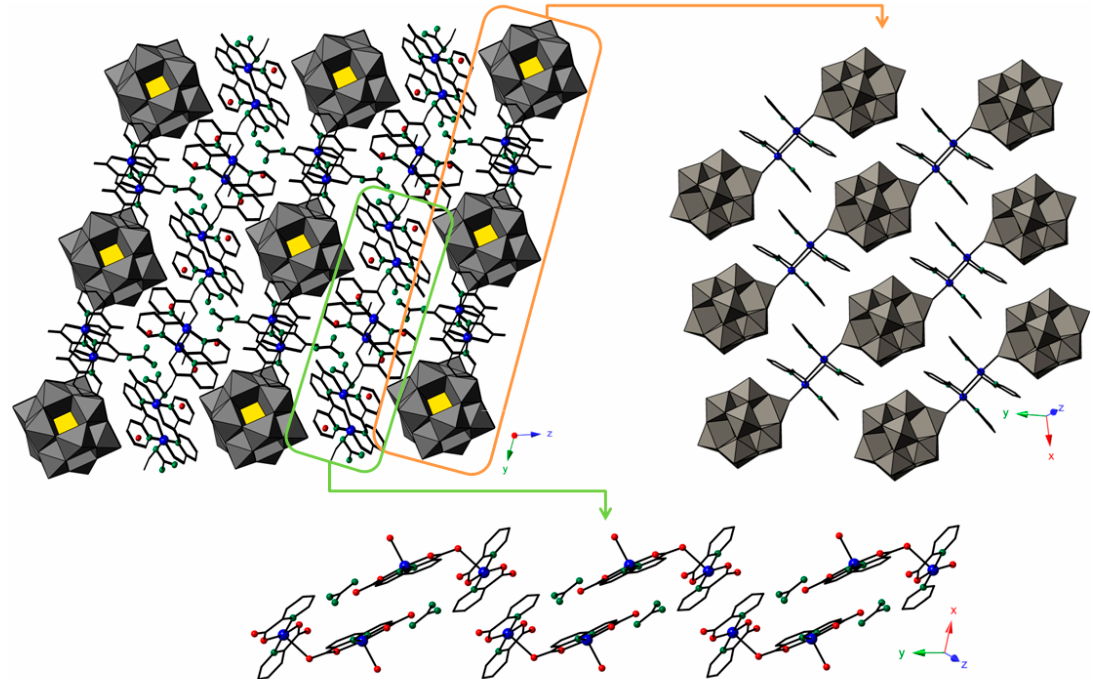
Figure 3. View of the crystal packing of 1 and 3 along the crystallographic a axis with details of the arrangement of the [{XW 12 O 40 }{Cu(pic) 2 } 2 ] 4 − chains in the hybrid layers and the [Cu 2 (pic) 4 (H 2 O)] units and [C(NH 2 ) 3 ] + cations in the metalorganic regions.